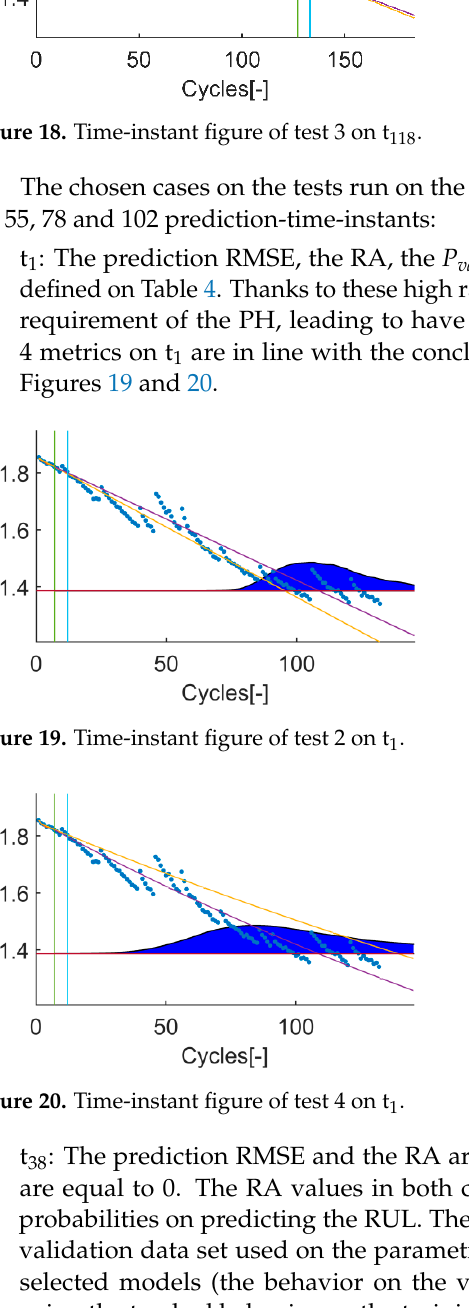
Figure 18. Time-instant figure of test 3 on t 118 .